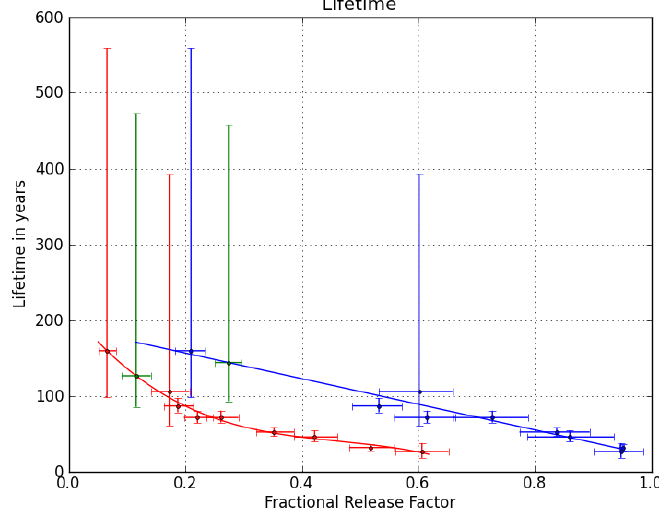
Figure 2. Correlation of fractional release factors (FRFs) with stratospheric lifetimes at mid-latitudes at a mean age of three years (red) and at high latitudes at a mean age of 5.5 years (blue) for nine ozone-relevant source gases, as derived in [24]. These correlations were used to estimate a stratospheric lifetime of 135 years and an uncertainty range of 85 to 472 years for CFC-216ba (green) from the FRFs inferred in Figure